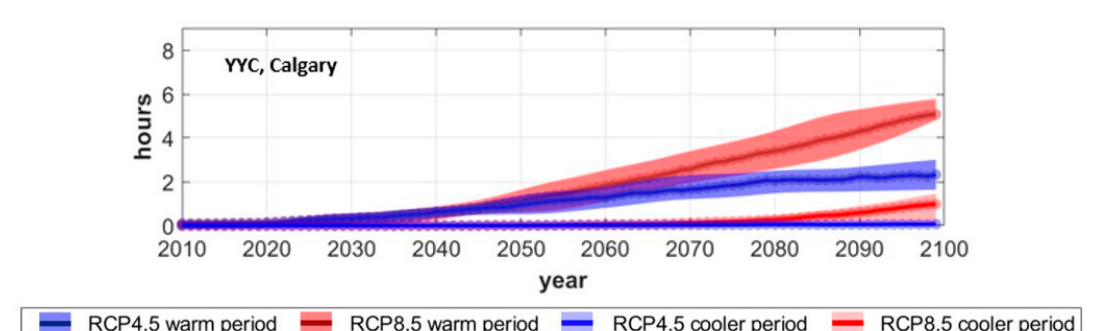
Figure 7. Same as Figure 6, but shows weight restriction hours during the warmer (dark shades of red and blue) and cooler (light shades of red and blue) periods of the day.